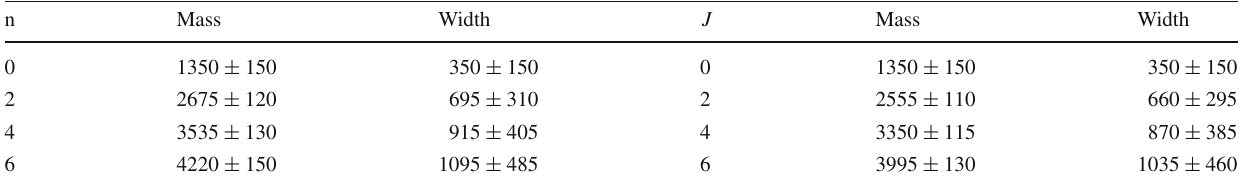
Table 7 Predictions using linear trajectories with glueball slope using f 0 ( 1370 ) as the ground state n